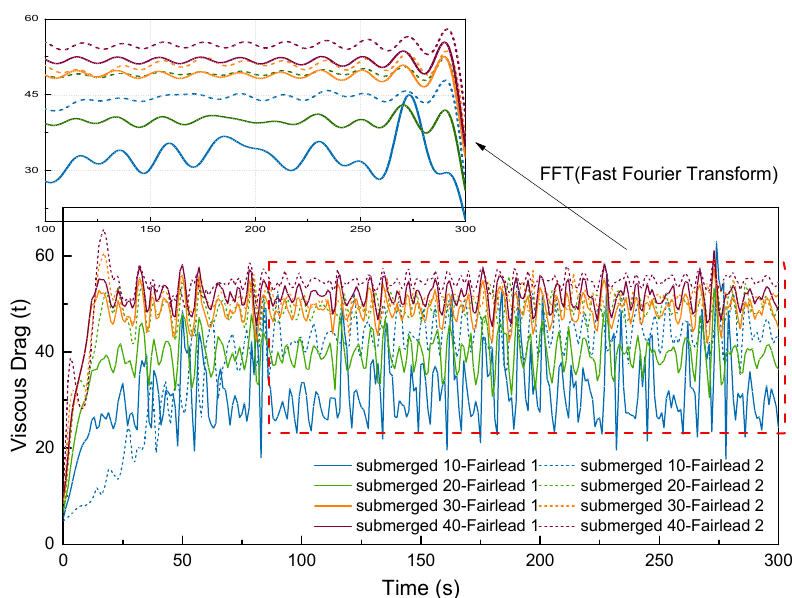
Figure 10. Comparison between the time history curves of the viscous drag force under different submerged depths in terms of the fairlead position (towing speed: 3 m/s).